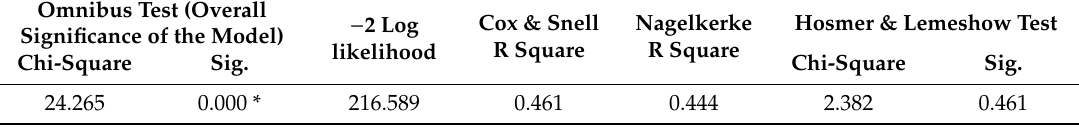
Table A3. Goodness of fit logistic regression model.